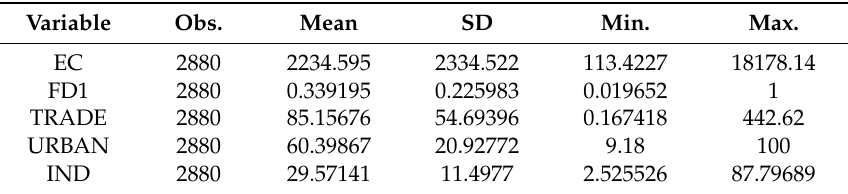
Table 3. Descriptive statistics of the main